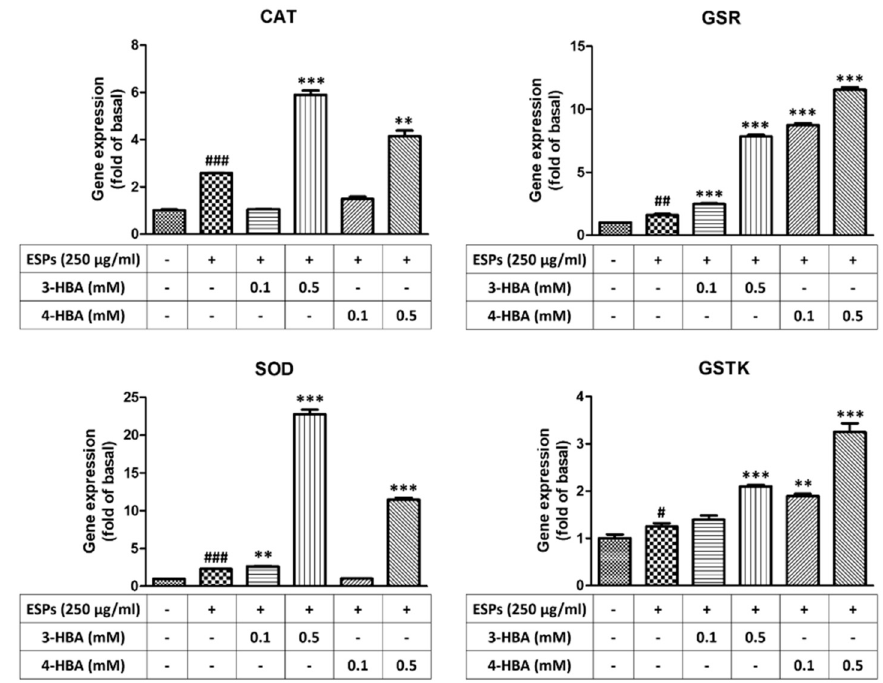
Figure 5. 3-HBA and 4-HBA induced the gene expression of antioxidants in ESP-treated astrocytes. Cells were pretreated with 3-HBA and 4-HBA (0.1 and 0.5 mM) for 4 h and then incubated with 250 µ g/mL ESPs for 12 h. mRNA expression was determined by real-time qPCR ( n = 3). + and - represent cells were pretreated or not with ESPs, 3-HBA or 4-HBA. # p < 0.05, ## p < 0.01, ### p < 0.001, compared to the control. ** p < 0.01, *** p < 0.001, compared to cells exposed to ESPs.